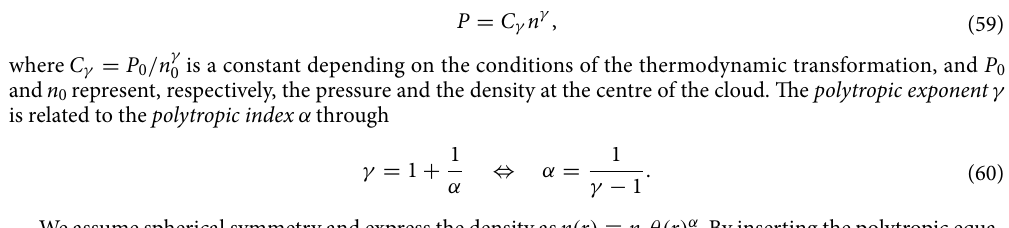
Figure 5. Numerical solutions of the generalized Lane–Emden equation (61) for ( a ) α 0.5 and different values of θ L 2 =